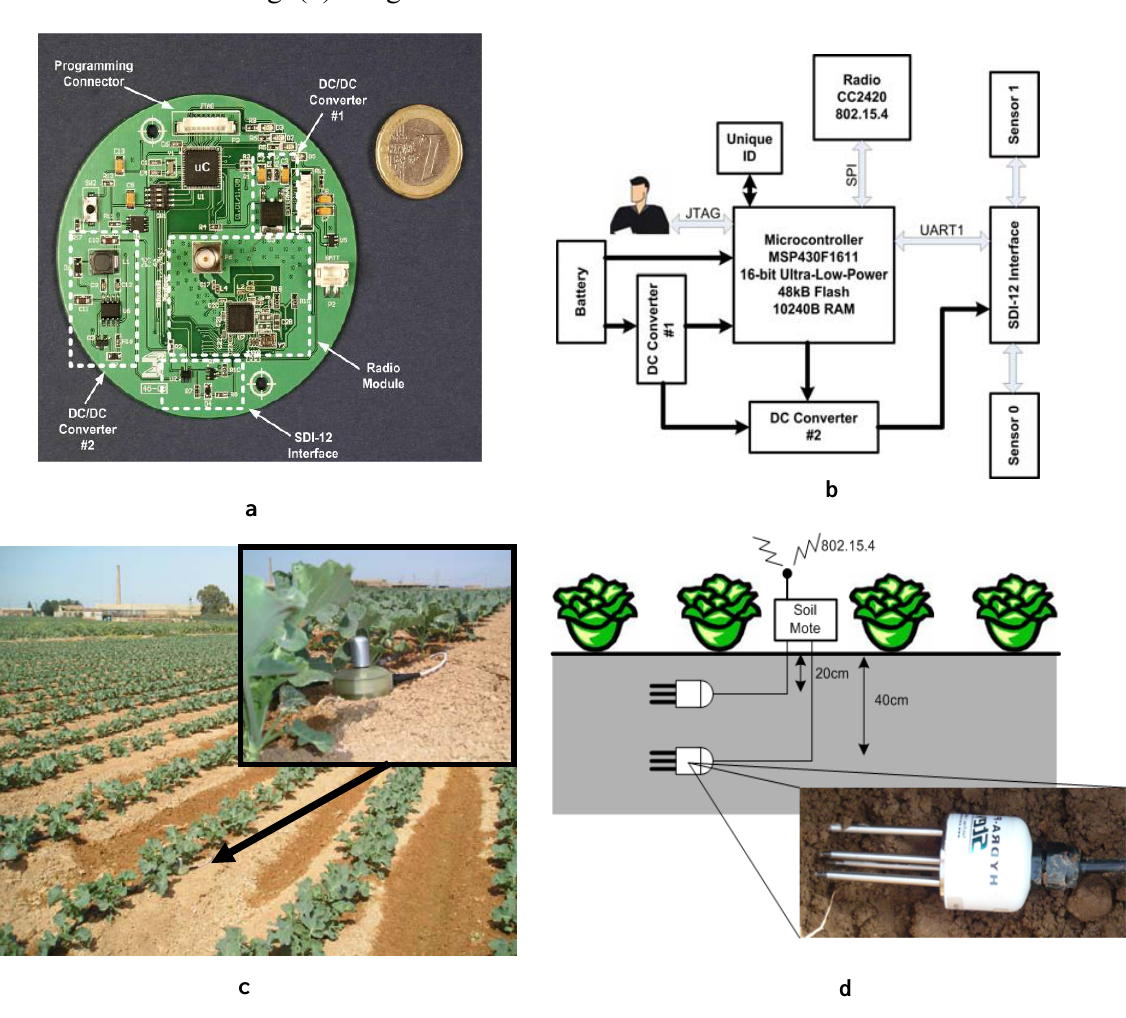
Figure 1. Different views of the GAIA Soil-Mote. (a) PCB. (b) Block diagram. (c) External view of casing. (d) Image of device in field with detail of the sensor